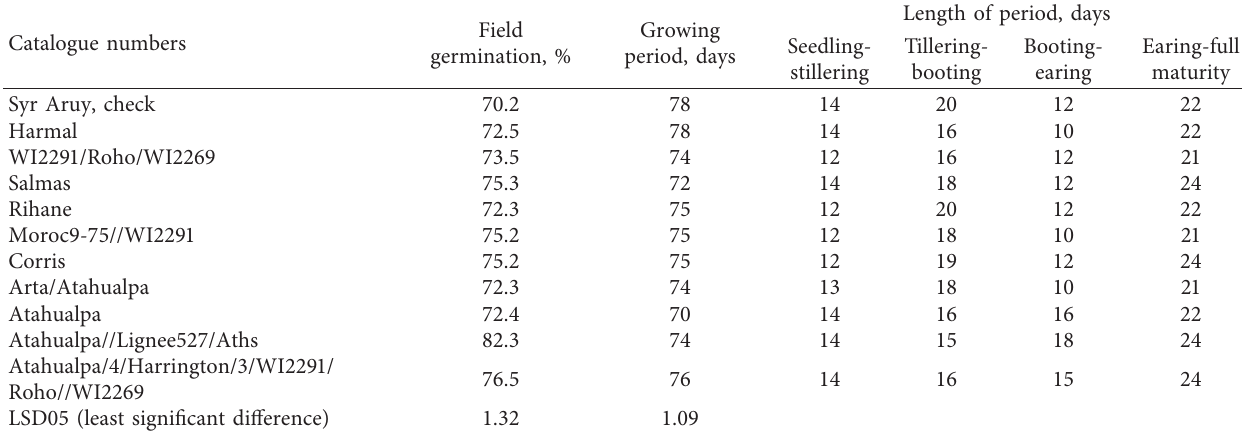
Table 2: The duration of the interstage periods of the development of selected early maturing samples of hull-less and hulled barley (average for